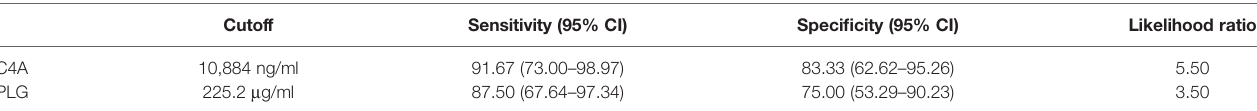
TABLE 4 | Diagnostic value of C4A and PLG for